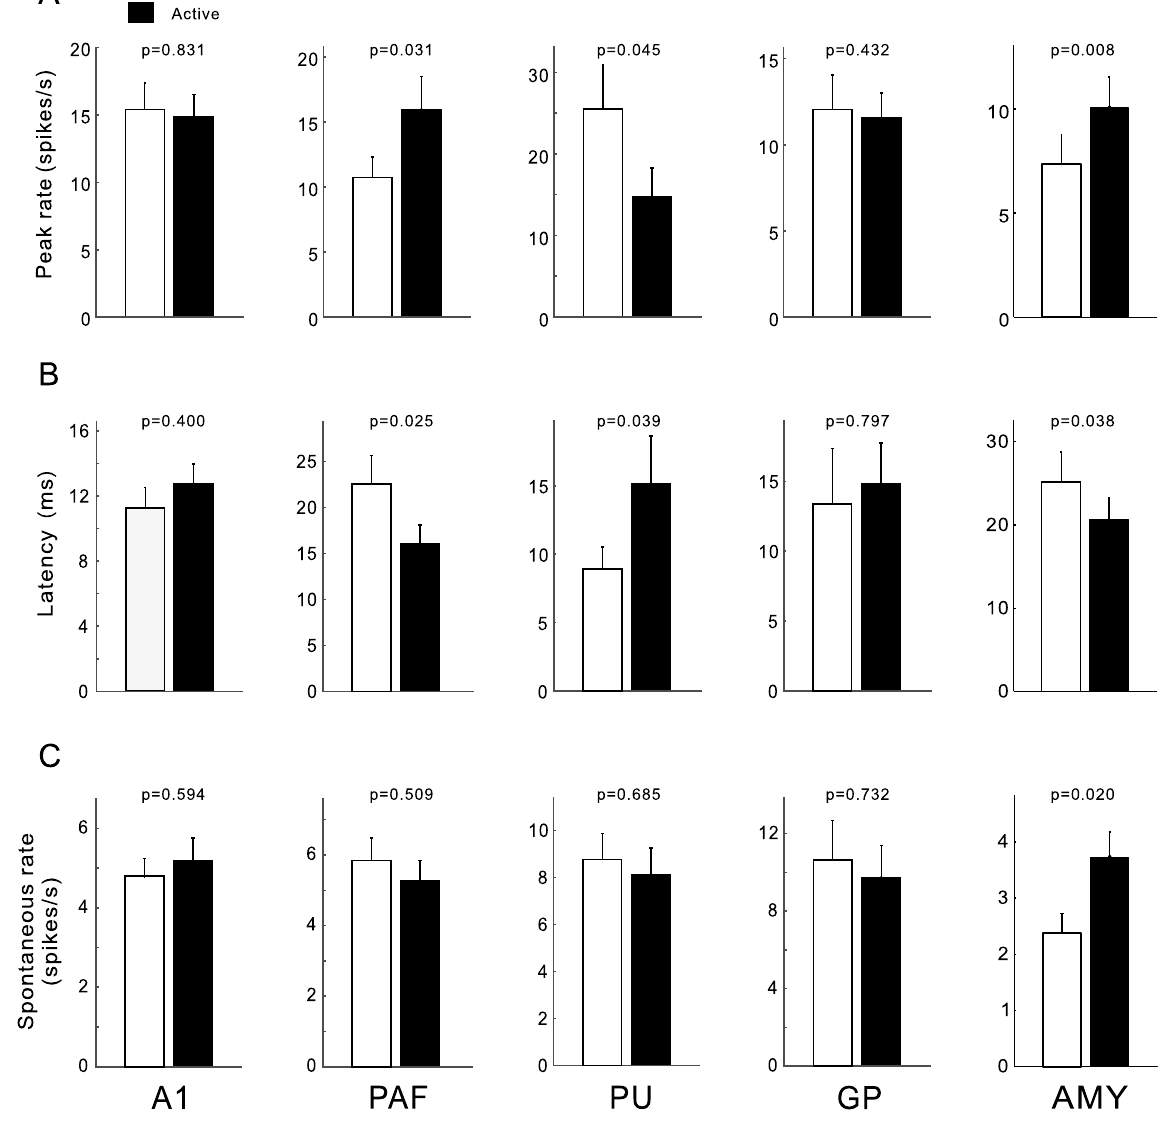
paired t -test between mean values of the active and passive